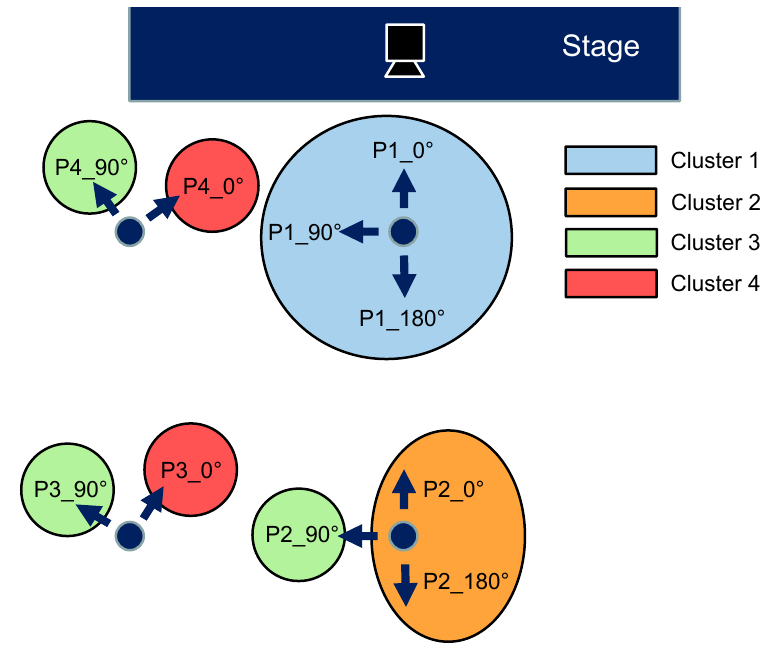
Figure 7. Visual representation of the position